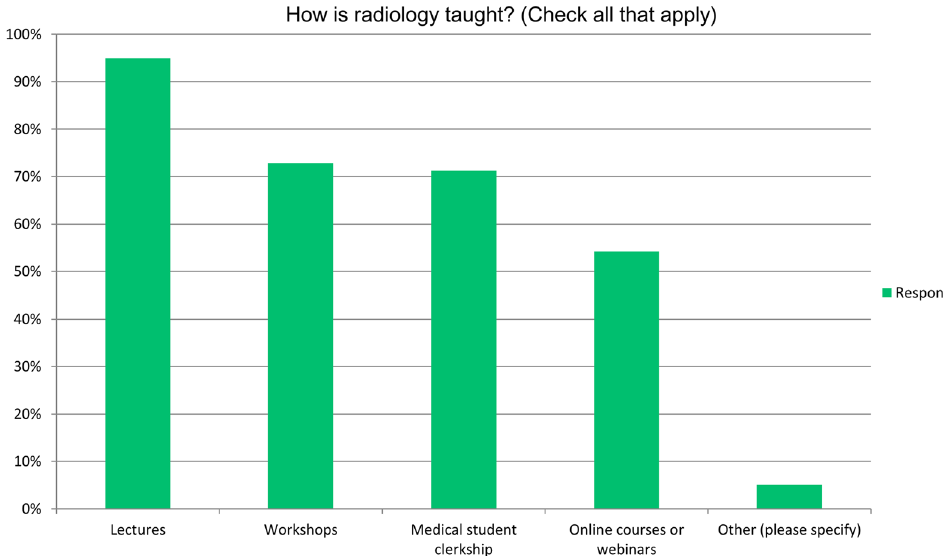
Fig. 2 Frequency plot showing distribution of teaching formats used to deliver radiology